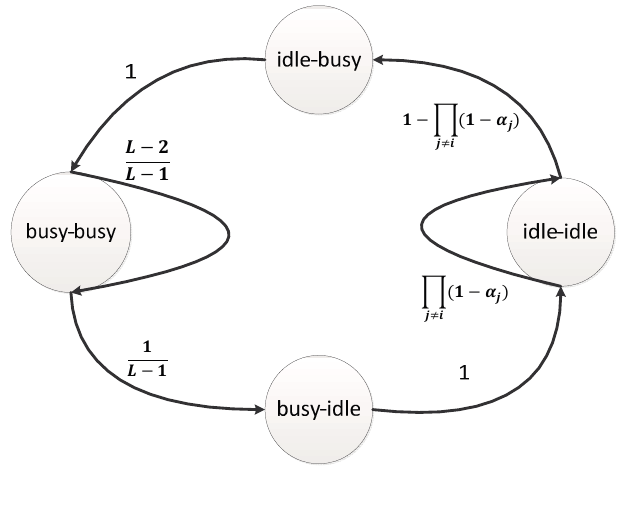
Figure 1. Channel state